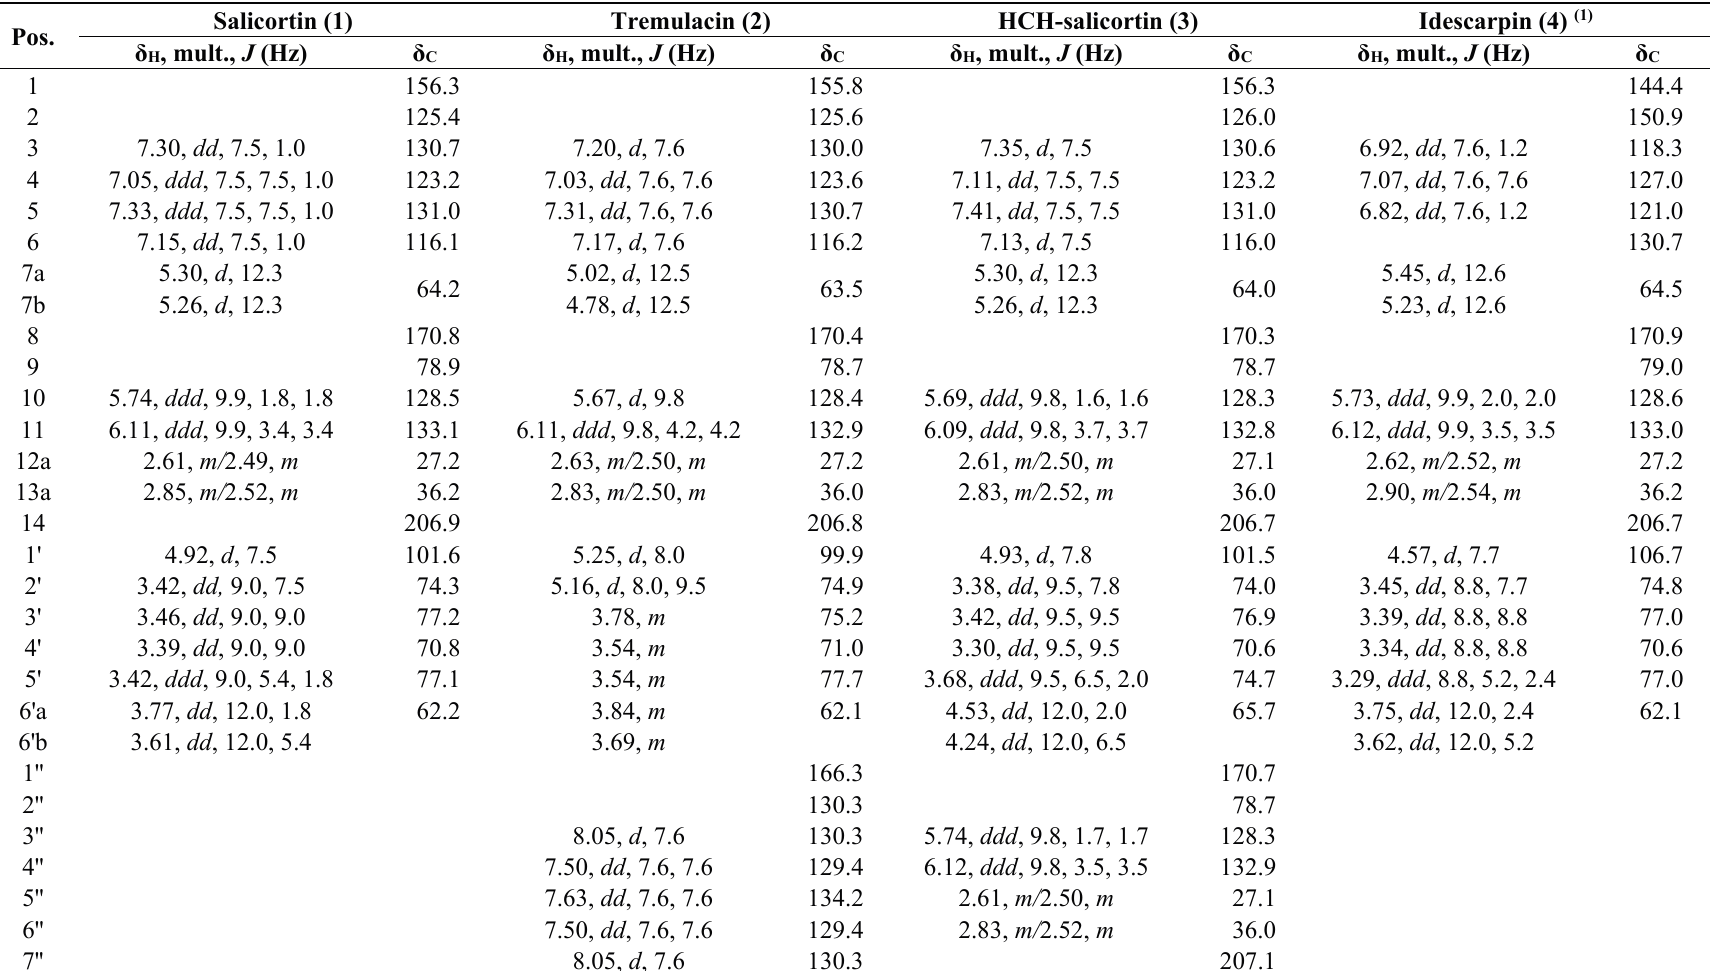
Table 1. 1 H and 13 C-NMR data of salicinoids in MeCN- d 3 . Salicortin ( 1 ) and idescarpin ( 4 ) and were measured at frequencies of 500 MHz for 1 H and 125 MHz for 13 C-NMR. HCH-salicortin ( 3 ) and tremulacin ( 2 ) were measured at 700 MHz and their 13 C-NMR data were obtained from Heteronuclear Single Quantum Coherence (HSQC) and Heteronuclear Multiple Bond Correlation (HMBC) spectra.